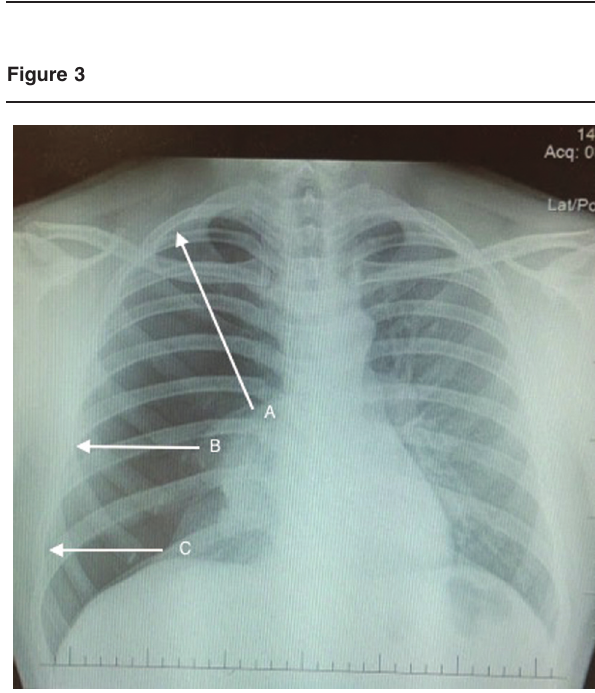
Study flow. Collin ’ s method is given by % PNX = 4.2+[4.7×(A+B+C)].